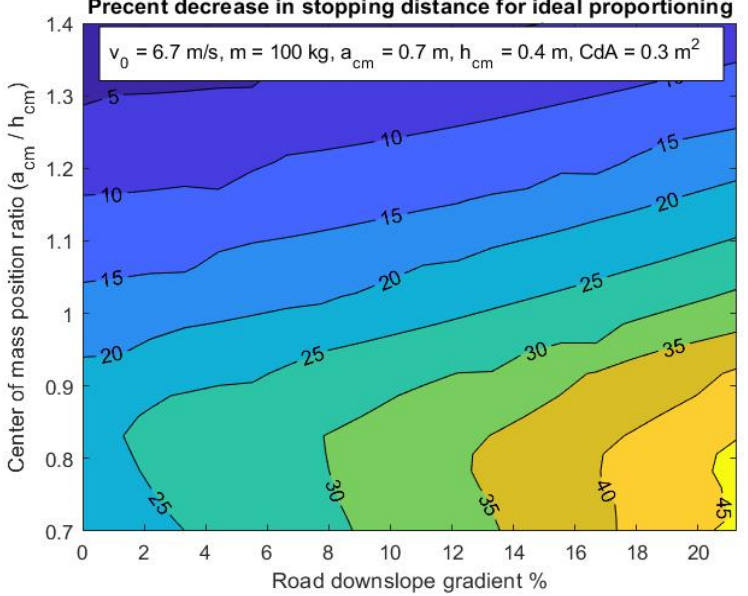
Figure 16. Percent decrease in stopping distances for an ideal proportioning valve with rear-wheel normal force sensing versus the prototype system showing the greatest advantage shown on steep downslopes and lower C.O.M. ratios.